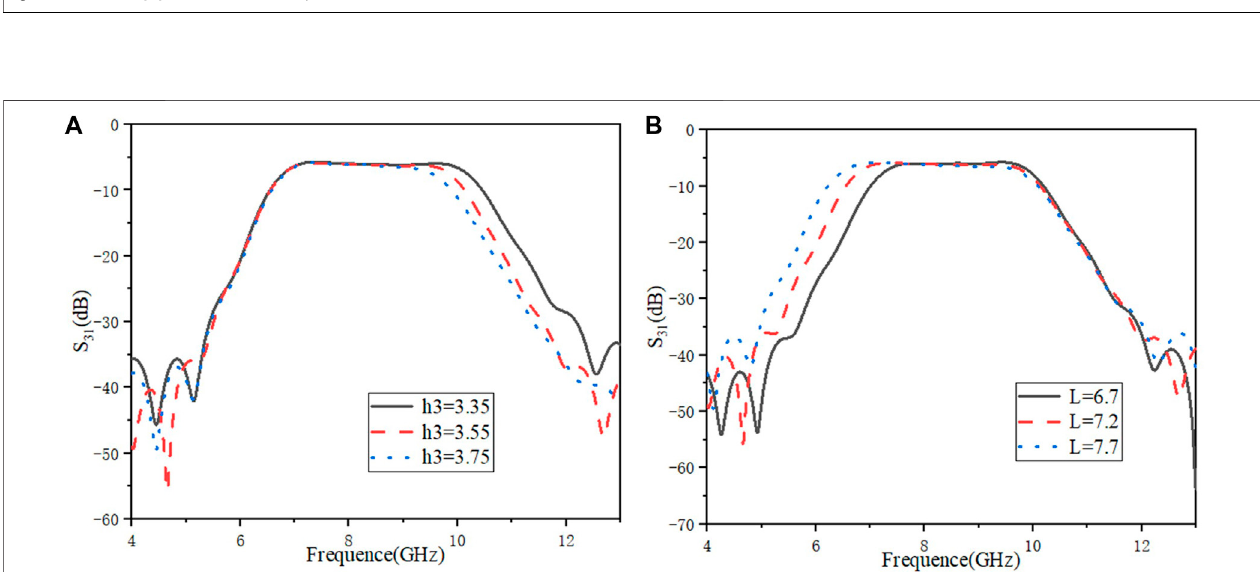
FIGURE 4 | Simulated transmission coef fi cients ( S 31 ) with different dimensions of (A) h3 and (B) L.